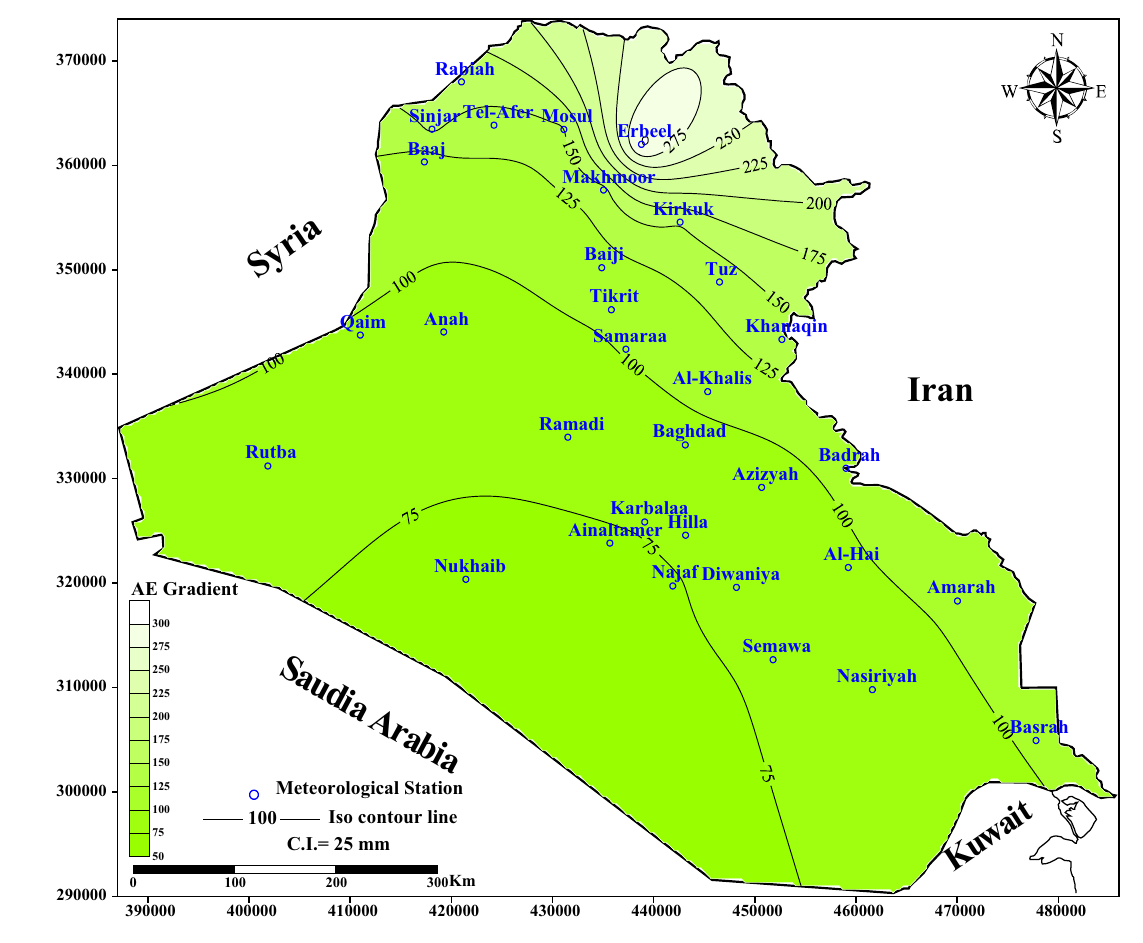
Fig. 3 Contour map of actual evapotranspiration (AE) in